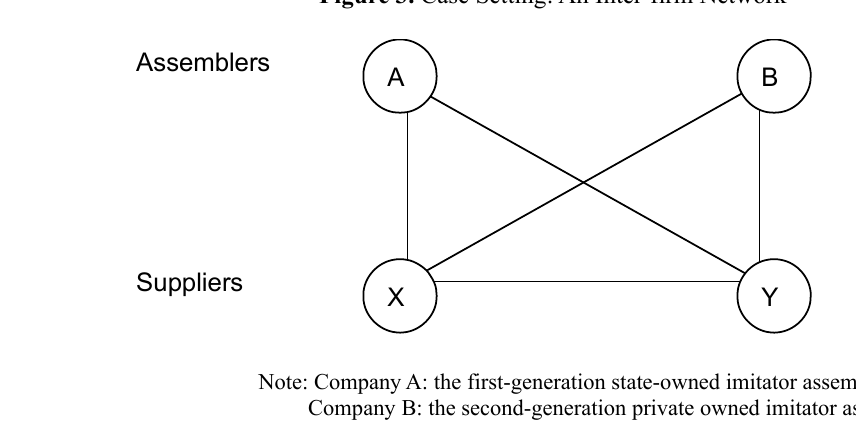
Figure 3. Case Setting: An Inter-firm